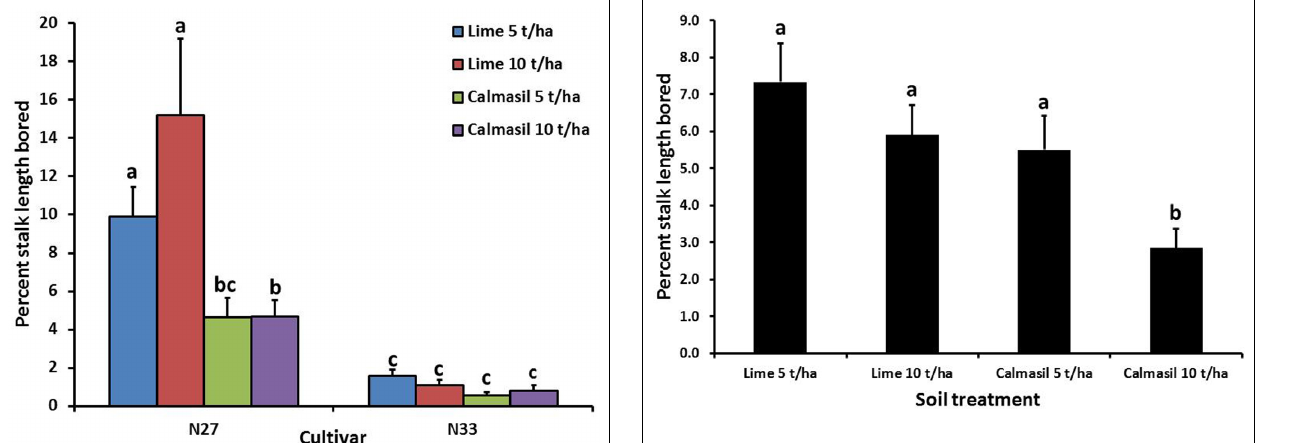
FIGURE 5 | Mean ( ± SE) percent stalk length bored by E. saccharina in sugarcane amended with Calmasil and lime at two different rates in Trial 2. Bars with the same letter/s above them do not differ significantly (Holm–Sidak test, p < 0.05). dolomitic lime applied at the same rates ( Table 1 ), the effects on leaf content of these elements were evident only for Ca in Trial